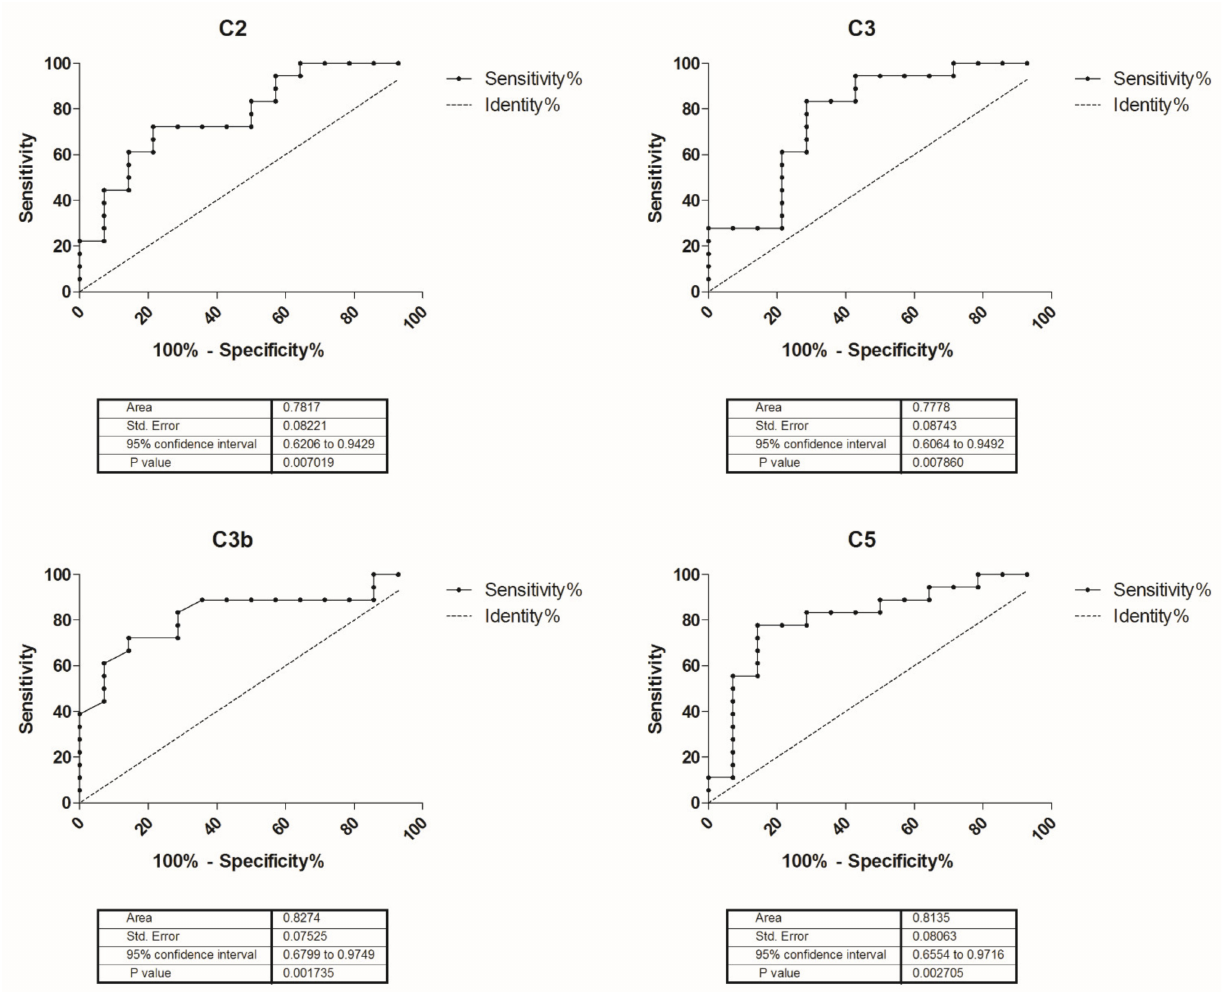
Figure 3. Potential value of C2, C3, C3b, and C5 as biomarkers for AChR-MG. Receiver operating characteristic (ROC) curves indicative of sensitivity and specificity of plasma C2, C3, C3b, and C5 as potential biomarkers able to discriminate AChR-MG and healthy controls. The true positive rate (sensitivity) on the y -axis is represented as a function of the false positive rate (100%-specificity%) on the x -axis. Higher y values correspond to a higher sensitivity, and lower x values correspond to a higher